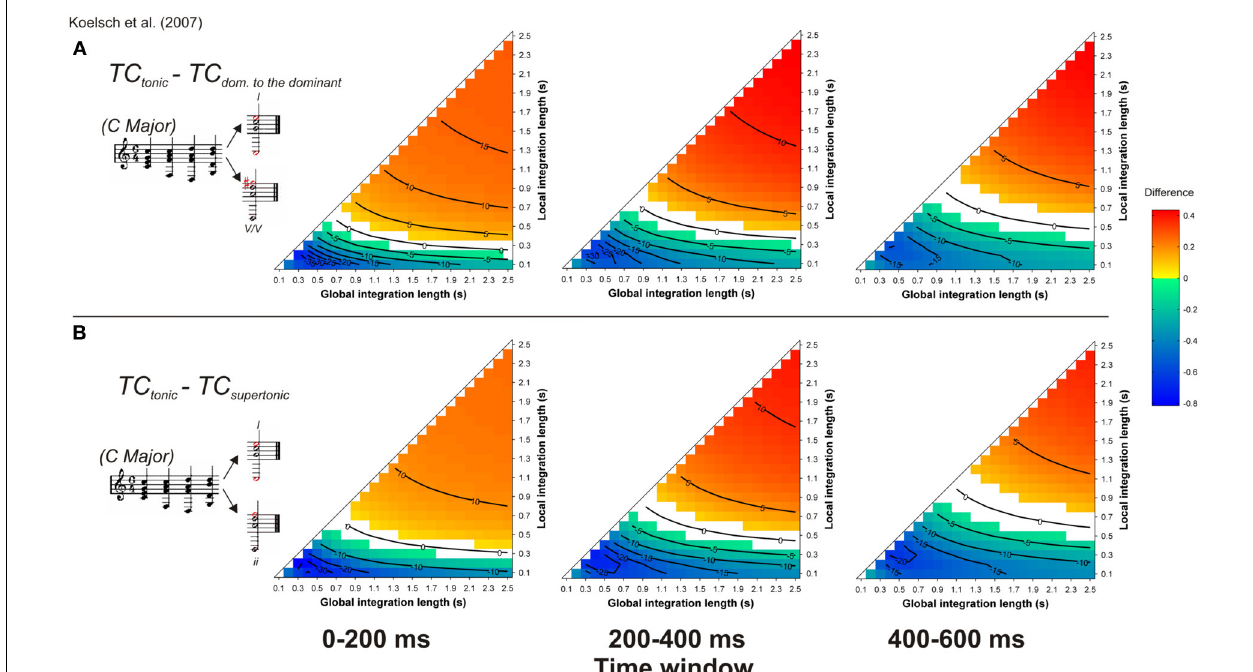
FIGURE 11 | Simulation of Koelsch et al. (2007). Mean TC differences between tonic and secondary dominant (A) and supertonic (B) target chords, as a function of the local and global context integration windows. Positive, negative, and nonsignificant differences are represented by hot, cold, and